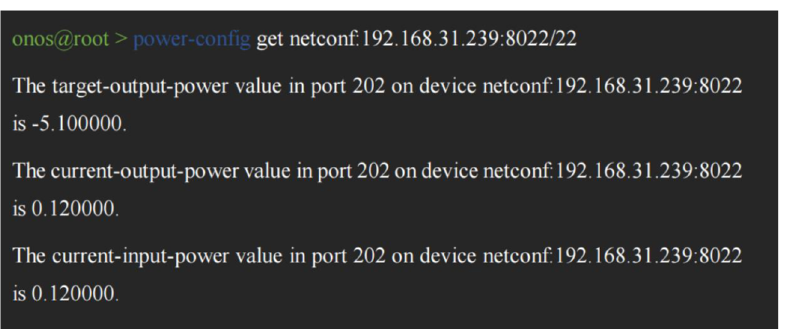
Figure 9. Snapshot of NETCONF-based queries about the status of the configuration in an optical agent commanded from ONOS.